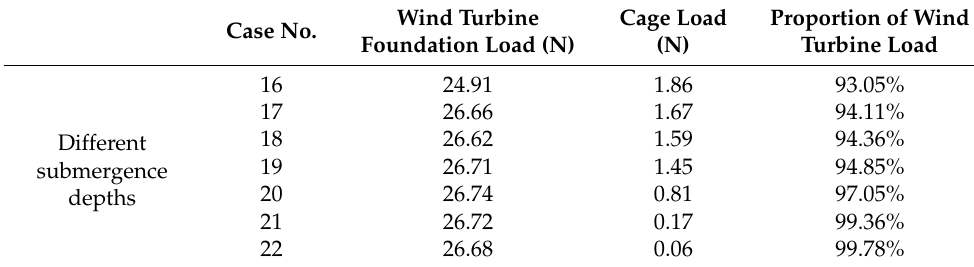
Table 6. Distribution and proportion of the maximum horizontal load on the combined structure caused by different cage submergence depths and cage plugging rates. Case